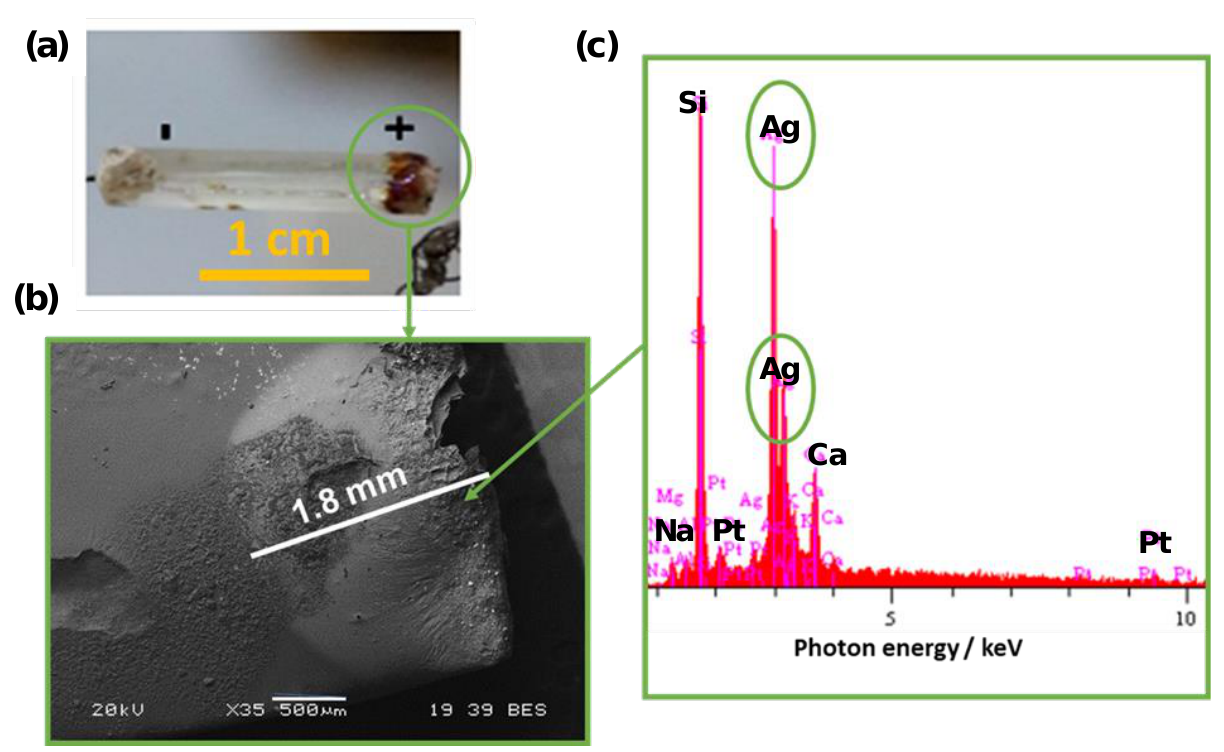
Figure 11. ( a ) Picture of an Ag-plated sample after flash treatment at 2 mA mm − 2 , where a brownish region is visible at the anode (+). ( b ) SEM micrograph and ( c ) EDXS spectrum of its anodic